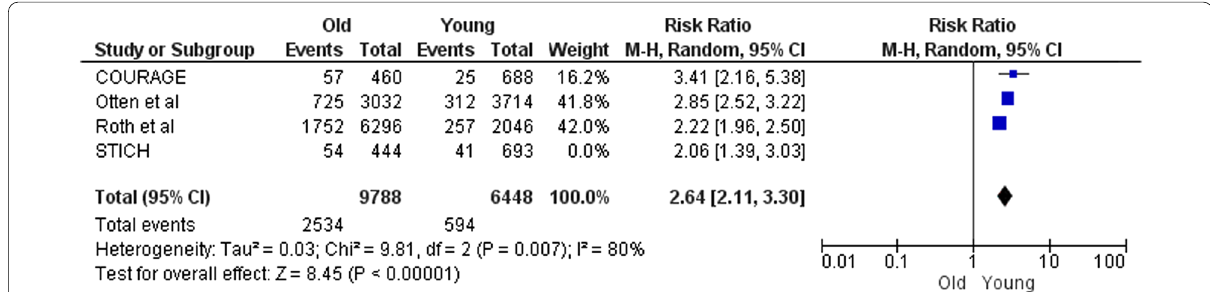
Fig. 8 Death after PCI in old versus young